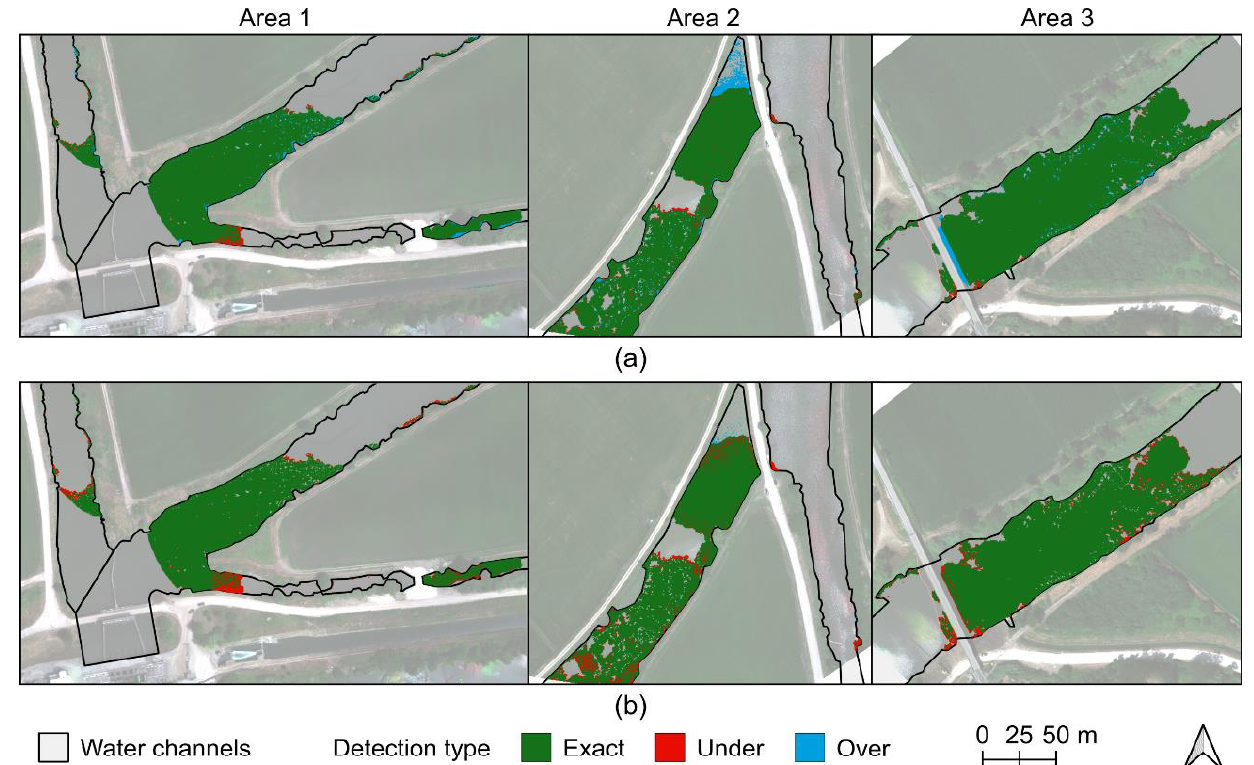
Figure 3. Water hyacinth classification results from normalized difference vegetation index (NDVI) thresholding ( a ) and from the random forest classifier ( b ) in the three areas surveyed by the unmanned aerial vehicle (UAV) on 21 July 2021.